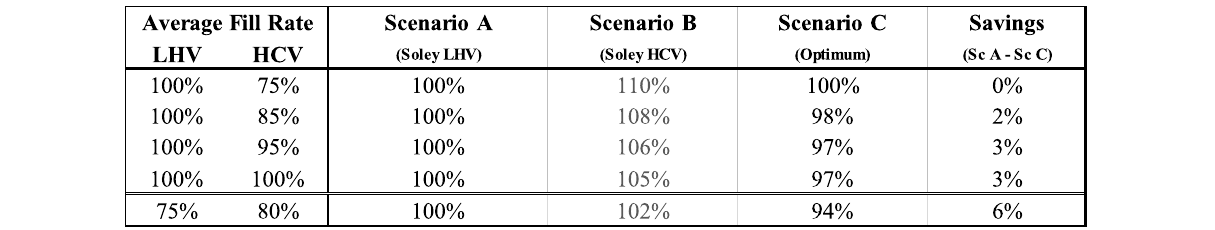
Table 3 Feasible fill rates for converting to HCT